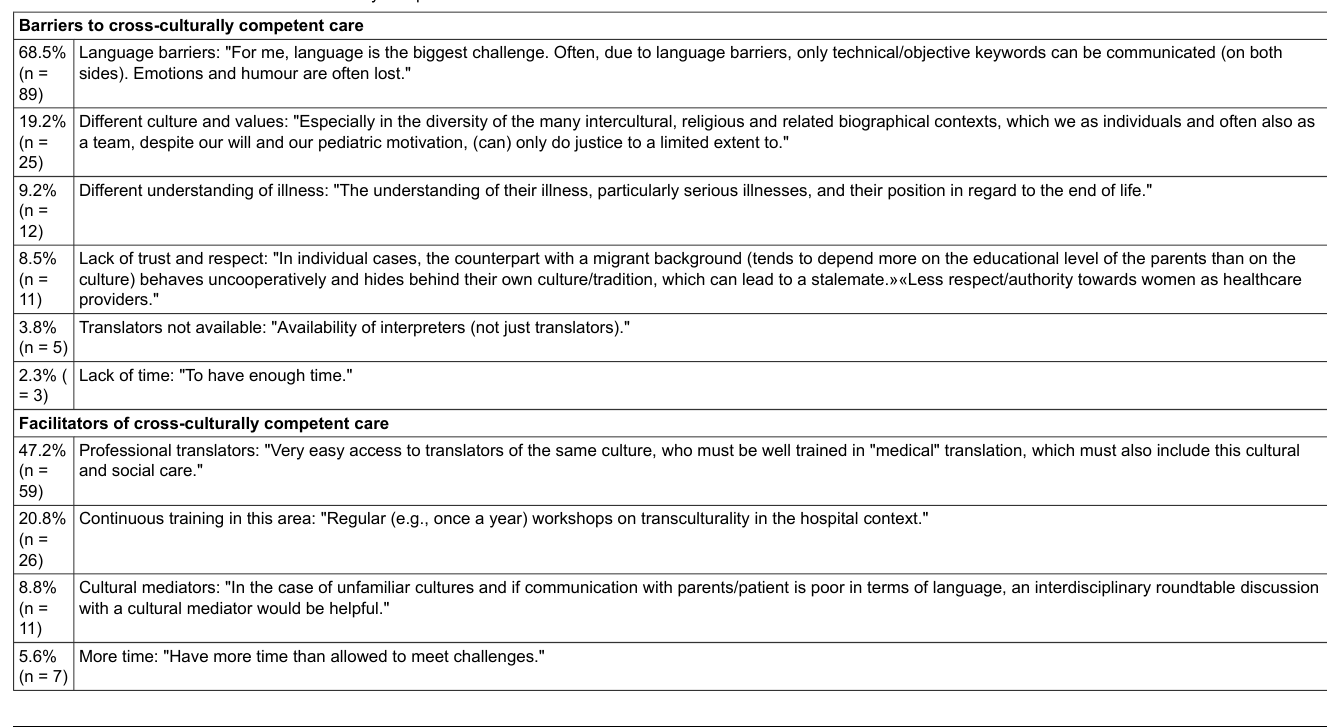
Table 3: Main barriers to and facilitators of cross-culturally competent care. Barriers to cross-culturally competent